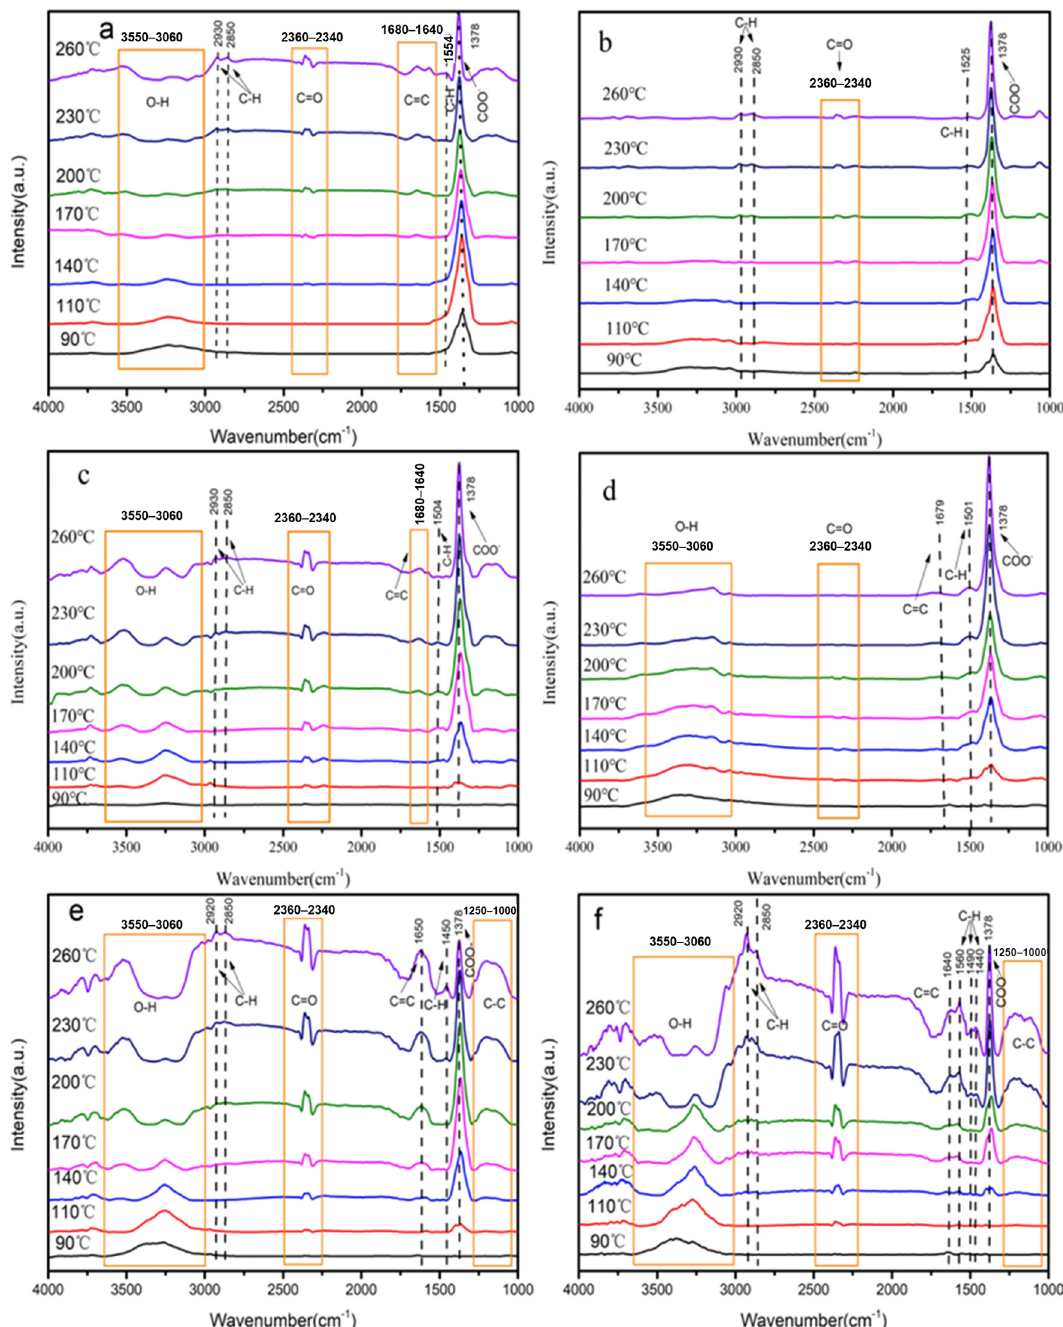
Figure 10. In situ DRIFTS spectra of 1,2-DCE catalytic oxidation over ( a ) Ru/ γ -Al 2 O 3 , ( b ) Rh/ γ -Al 2 O 3 , ( c ) Pt/ γ -Al 2 O 3 , ( d ) Pd/ γ -Al 2 O 3 , ( e ) Ir/ γ -Al 2 O 3 , ( f ) Au/ γ -Al 2 O 3 catalysts.